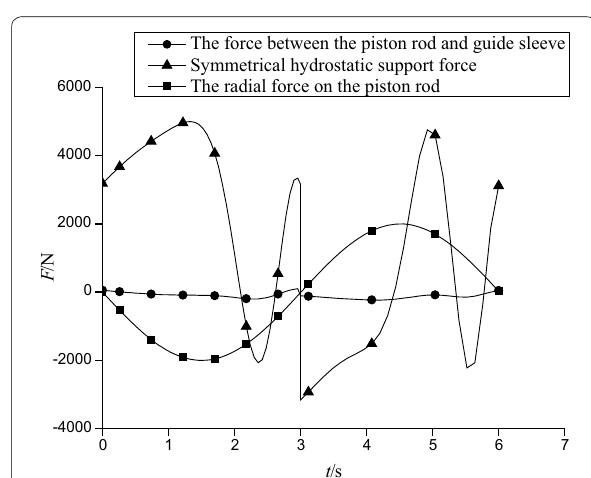
Figure 13 Conventional static-pressure four-pad symmetrical structure force